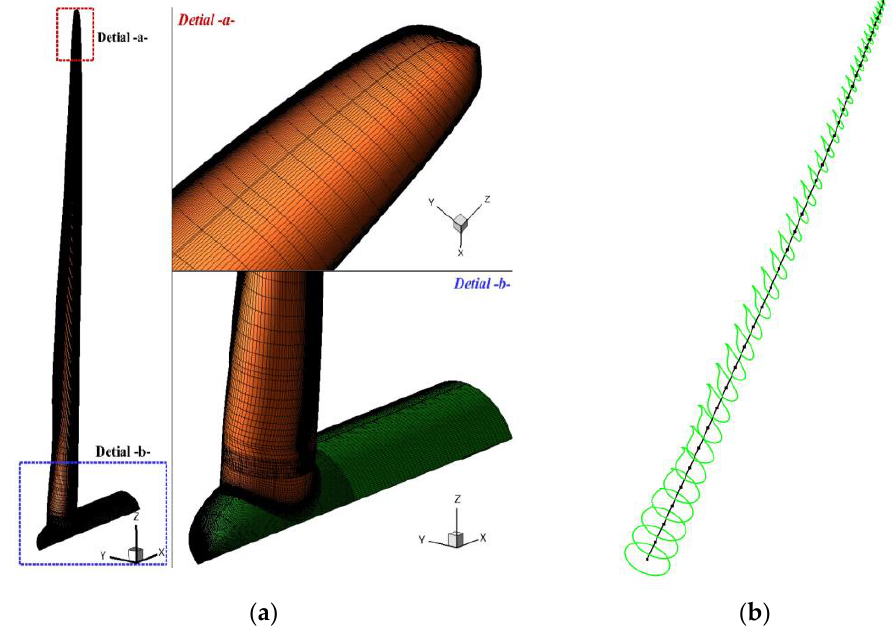
Figure 7. CFD-CSD mesh: ( a ) CFD surface mesh; ( b ) CSD beam finite elements (black lines), and the green sections are the predefined cross sections [71].